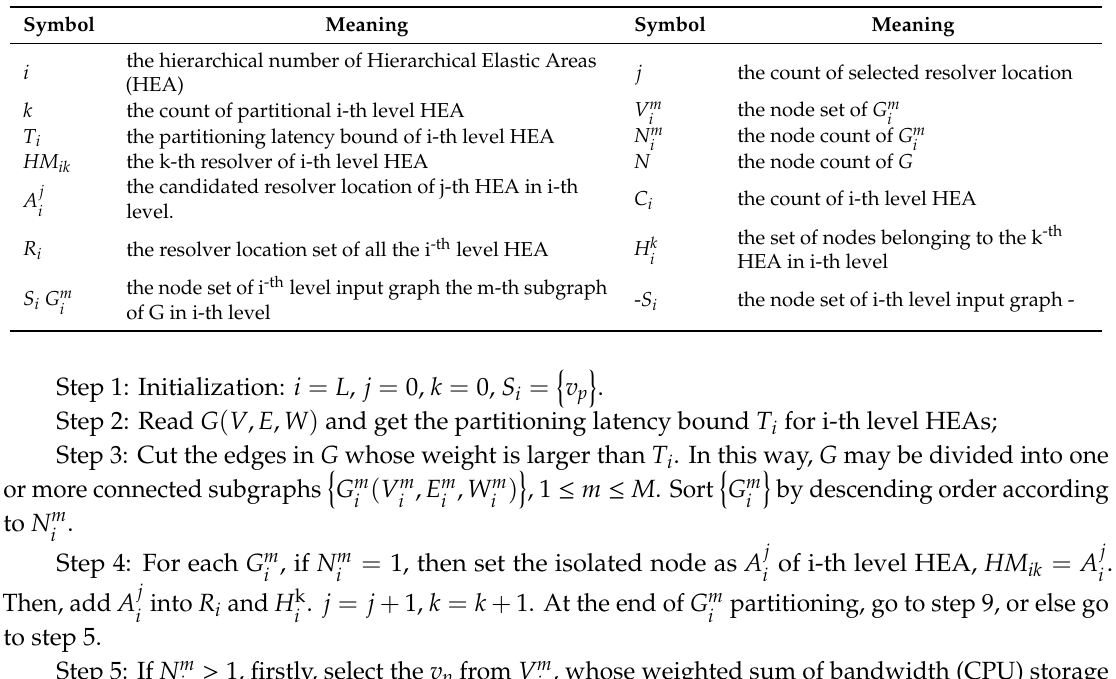
Table 1. The meaning of symbols in Algorithm